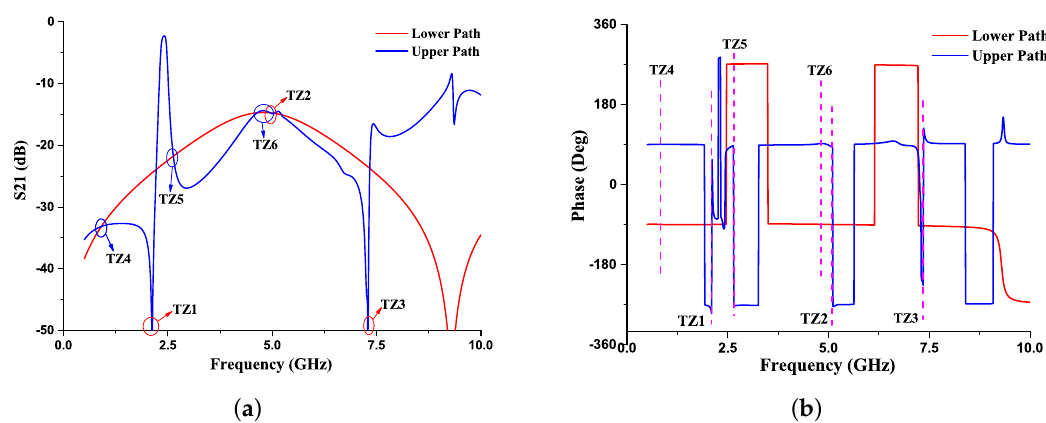
Figure 4. HFSS Simulated results of lower path (red line) and upper path (blue line). ( a ) Amplitude of